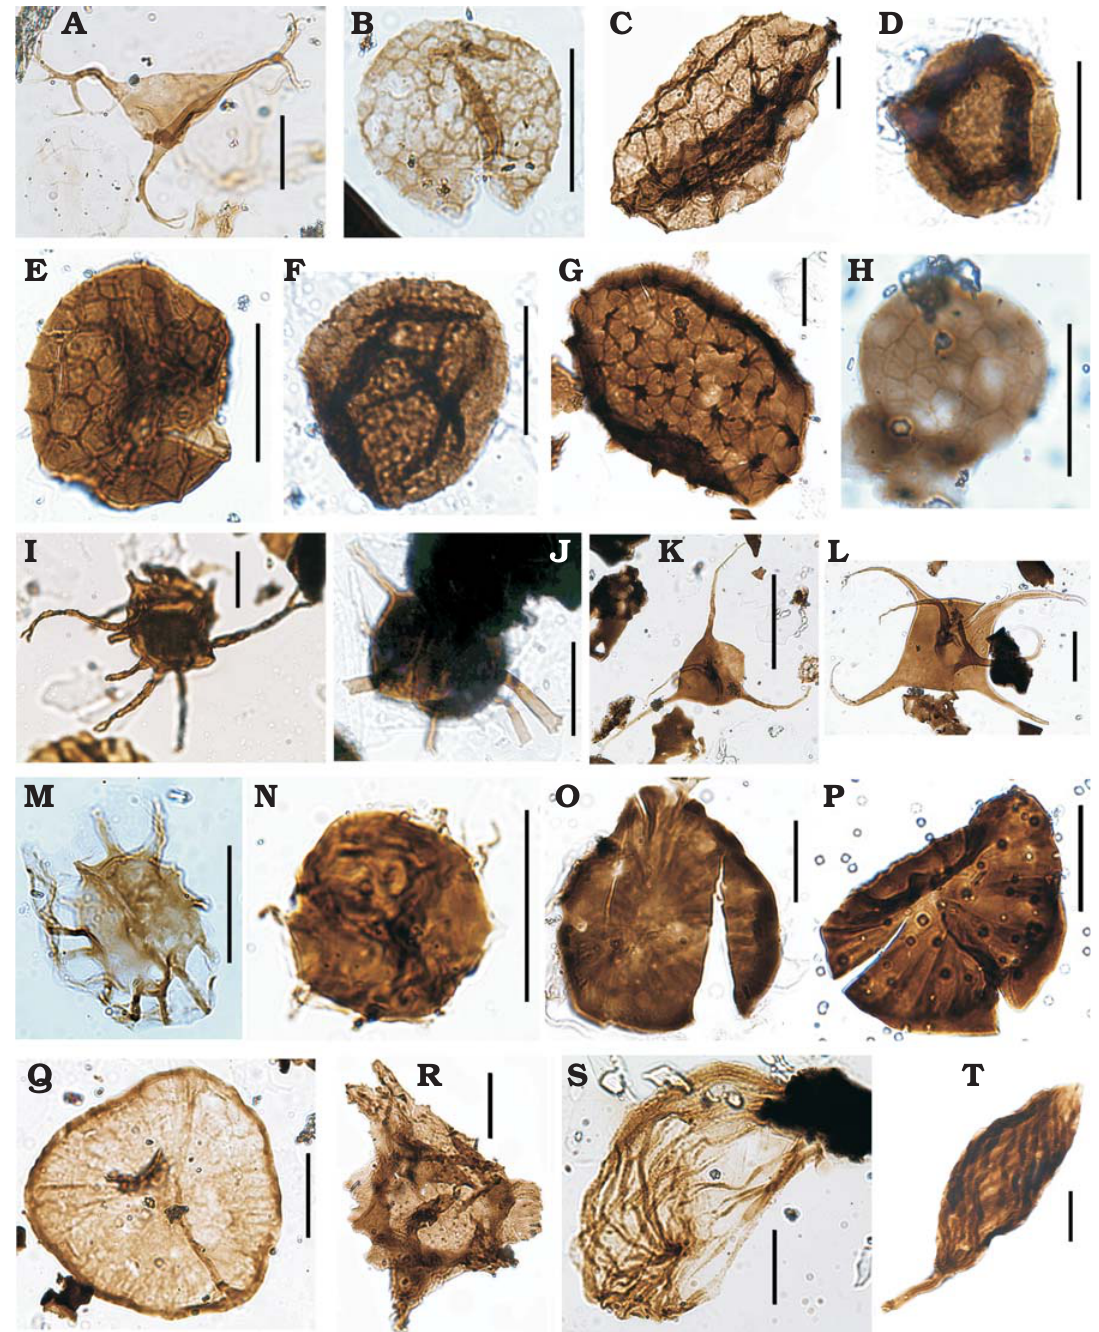
Fig. 7. Palynomorphs from the studied sections of the Los Espejos Formation of Argentina, from Cerro La Chilca, Ludfordian (A, M, O), Cerro La Chilca, Gorstian?–Ludfordian? (B, N, P, S), Quebrada Ancha, Ludfordian (C, D, F, H, J, K, L, Q, R), Quebrada Ancha, P ř ídolí (E, G, I), Quebrada Ancha, Gorstian?– Ludfordian? (T). A . Dateriocradus lindus (Cramer and Díez, 1976) Sarjeant and Vavrdová, 1997; MPLP 4-61059 (Q42/3). B . Dictyotidium alveolatum (Kiryanov, 1978) Le Hérissé, 1989; MPLP 2-61057 (O41). C . Dictyotidium biscutulatum Kiryanov, 1978; MPLP 7-60736 (Q27). D . Dictyotidium callum Al-Ruwaili, 2000; MPLP 3-60659 (P45/1). E . Dictyotidium dictyotidium (Eisenack, 1938) Eisenack, 1955; MPLP 12-60986 (J28/4). F . Dictyotidium faviforme Schultz, 1967; MPLP 2-60704 (H38/3). G . Dictyotidium stellatum Le Hérissé, 1989; MPLP 10-60673 (D39/3). H . Dictyotidium tenuior- natum Eisenack, 1955; MPLP 6-60662 (G25/1). I . Diexallophasis remota Group Mullins, 2001; MPLP 10-60673 (H34). J . Dilatisphaera williereae (Martin, 1966) Lister, 1970; MPLP 2-60704 (Q39/2). K . Dorsennidium europaeum (Stockmans and Willière, 1960) Mullins, 2001; MPLP 7-60736 (L34/4). L . Dorsennidium pertonense (Dorning, 1981) Sarjeant and Stancliffe, 1996; MPLP 7-60736 (U41). M . Duvernaysphaera aranaides (Cramer, 1964a) emend. Cramer and Díez, 1972; MPLP 4-61059 (C47/3). N . cf. Eisenackidium argentinum Pöthe de Baldis, 1997; MPLP 2-61057 (Q42). O . Emphanisporites rotatus (McGregor, 1961) McGregor, 1973; MPLP 4-61059 (W47/2). P , Q . Emphanisporites sp.; MPLP 2-61057 (Q42), MPLP 7-60736 (K43), respectively. R . Estiastra barbata (Downie, 1963) Sarjeant and Stancliffe, 1994; MPLP 8-60677 (X37/3). S . Dactylofusa sp.; MPLP 3-61058 (T35/3). T . Eupoikilofusa cf. stratifera (Cramer, 1964b) Cramer, 1970; MPLP 1-60667 (R48). Scale bars 20 μ